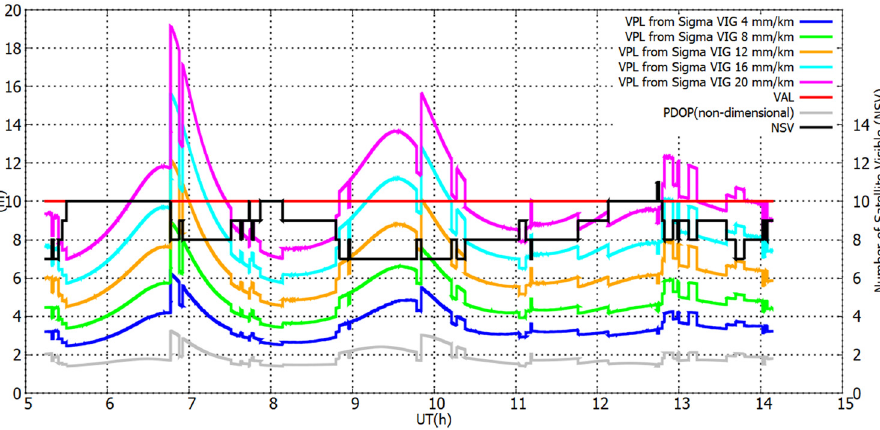
Figure 15: Comparison of VPL according to the adopted σ vig and the in fl uence of satellite geometry.